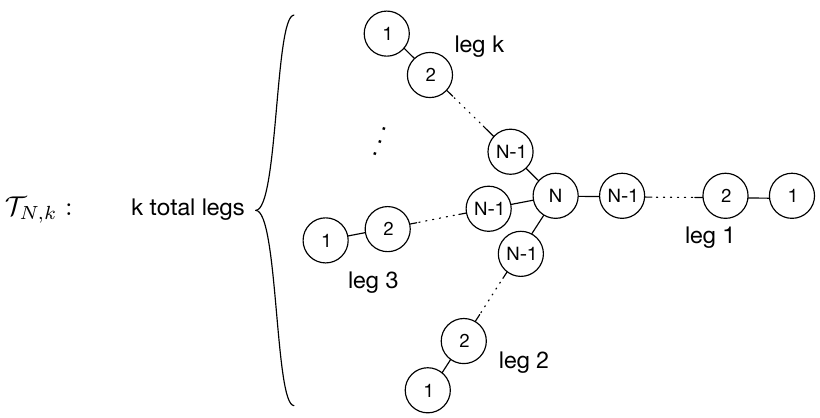
Figure 1 . The quiver gauge theory , associated with a star quiver with k legs of length N , has T N; k (cid:0) (cid:1) gauge group U( N ) [U( N 1) : : : U(1)] k = U(1), and hypermultiplet matter in a bifundamental (cid:2) (cid:0) (cid:2) (cid:2) representation for each edge in the